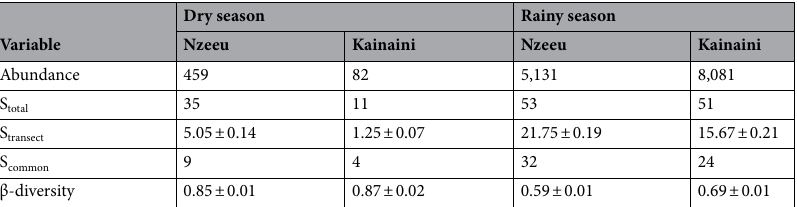
Table 1. Basic data on the sample sizes (abundances), the total species richness S total , the average species richness per transect S transect , the number of species common to the three transect lines, and the respective β-diversity among transects for the four study site–season combinations. Errors refer to bootstrapped standard errors of the mean.